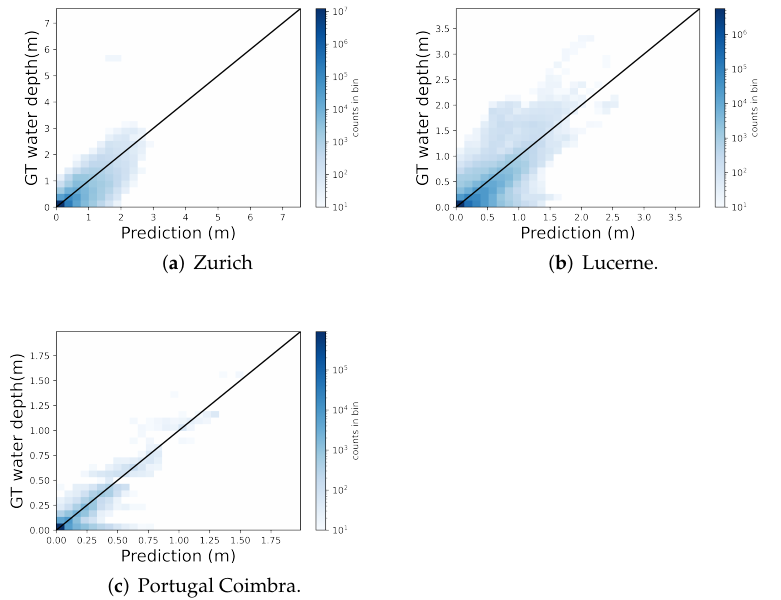
Figure 5. Ground-truth vs. predicted flood hazard maps for rainfall event tr2_1 in ( a ) Zurich, ( b ) Lucerne and ( c ) Portugal catchment. The black diagonal line represents the ideal prediction.